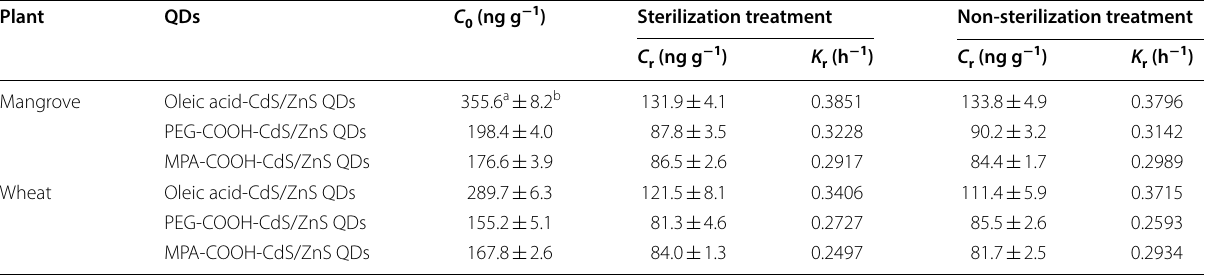
a Mean values of the concentrations of CdS/ZnS QDs located on root epidermis of six groups b Standard deviations of the concentrations of CdS/ZnS QDs located on root epidermis of six groups